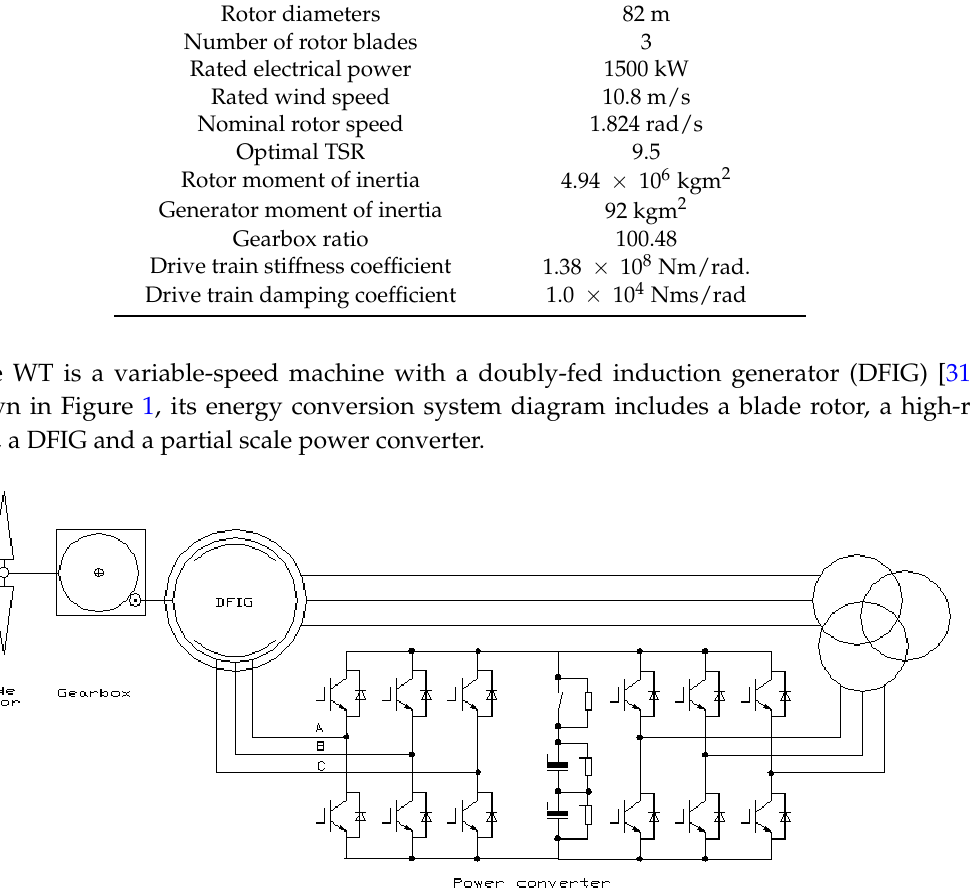
Figure 1. Energy conversion system diagram of the concerned WT.